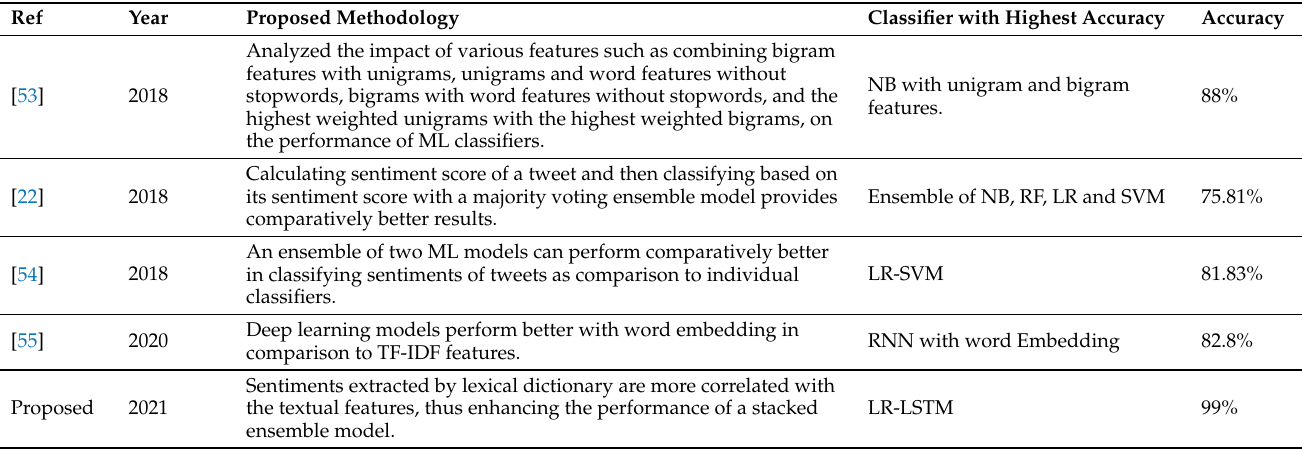
Table 17. Comparative Analysis of the Proposed Study with Correlated